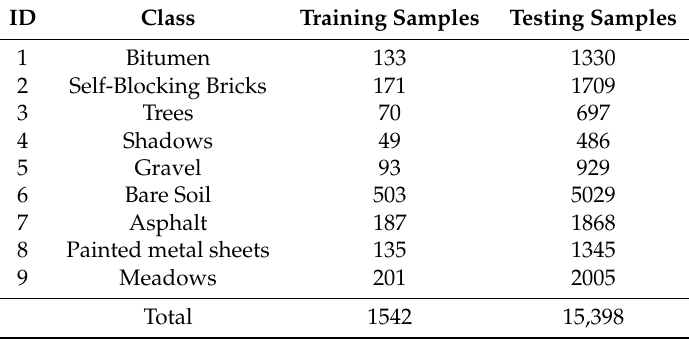
Figure 12. Classification reference data:( a ) ground truth of the area; ( b ) nine classes in ROSIS HSI. Table 1. Training and testing samples used in the classification.